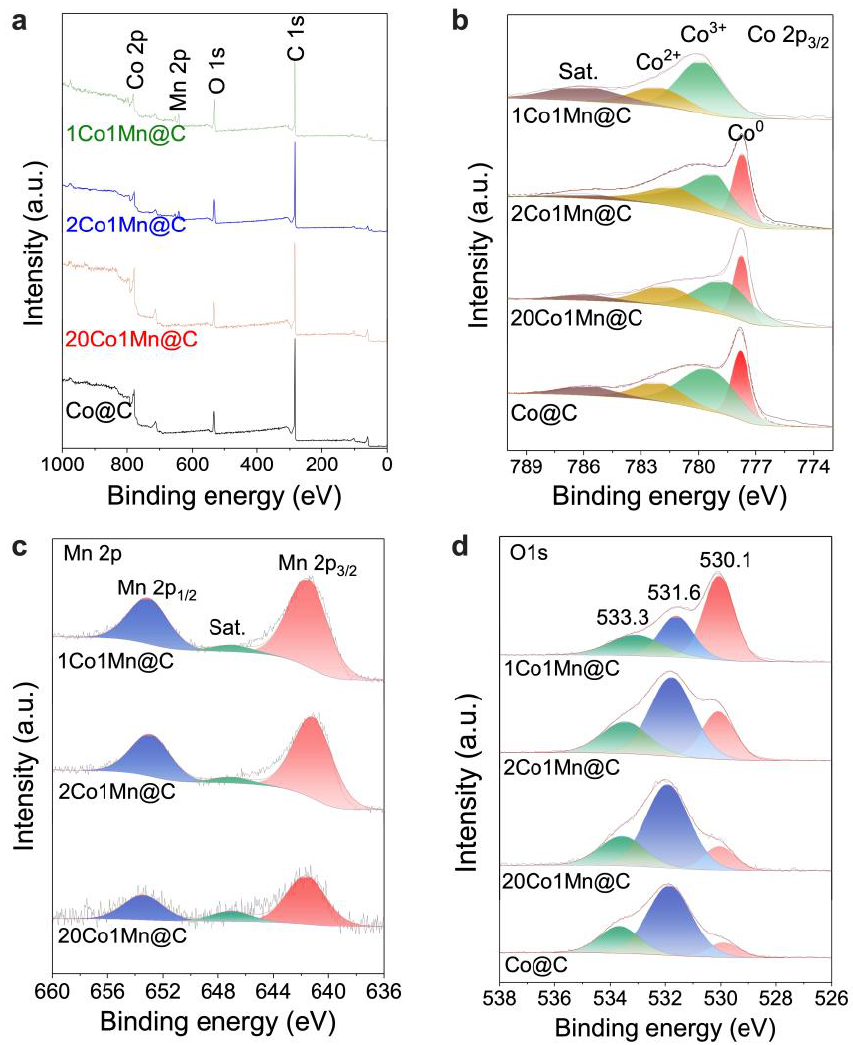
Figure 5. ( a ) High-resolution spectra, ( b ) Co 2p, ( c ) Mn 2p, and ( d ) O 1s XPS spectra of Co@C and BMOF-derived CoMn@C catalysts.